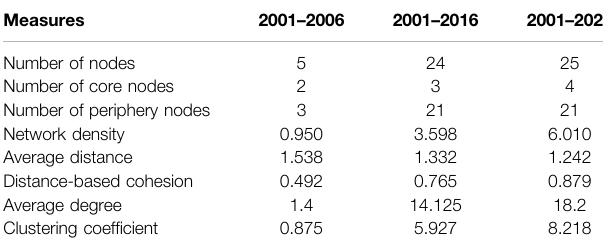
TABLE 6 | Results of network topological analysis of China ’ s HFCV